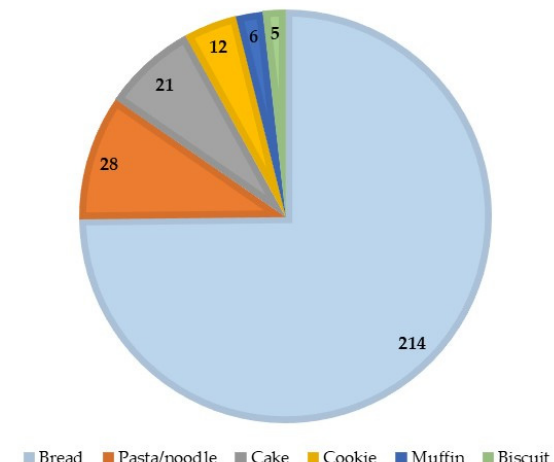
Figure 2. Number of publications dealing with hydrocolloid applications in different GF products. Results were obtained on 19 October 2021 on the Web of Science database.